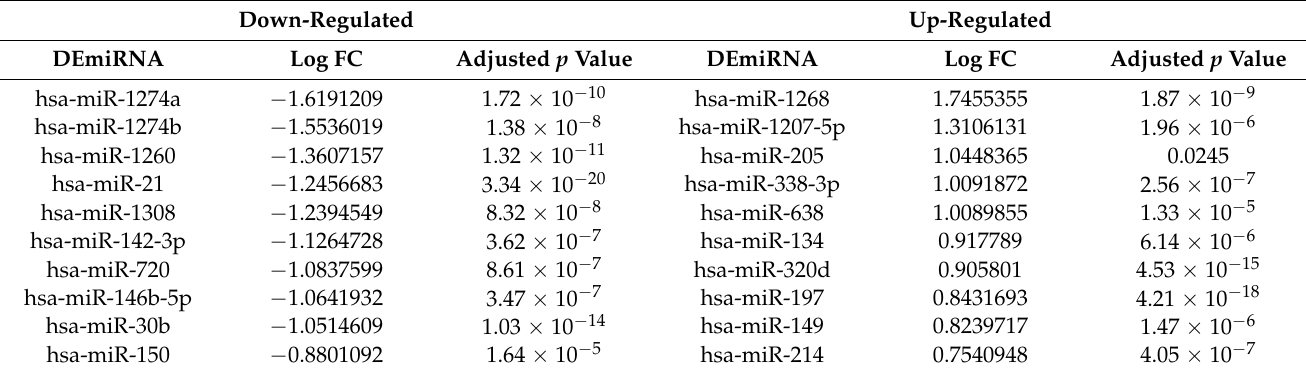
Table 4. The top 10 up- and downregulated DEmiRNAs between prostate and normal